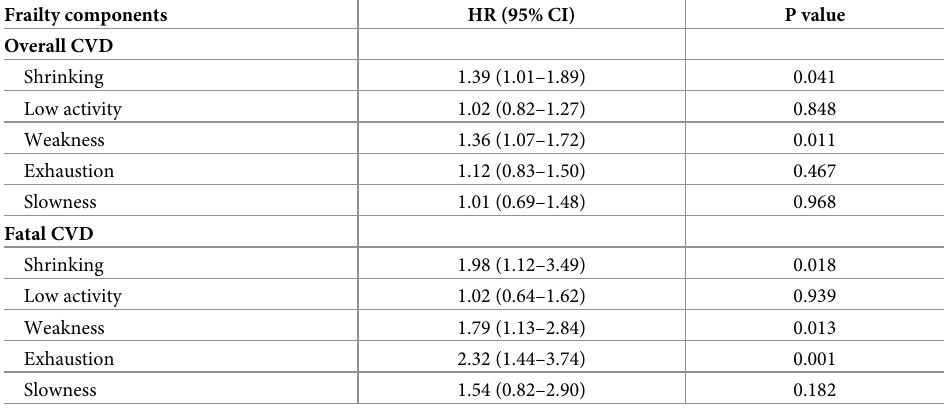
Table 4. Association between frailty components at baseline and incidence of CVD events in the